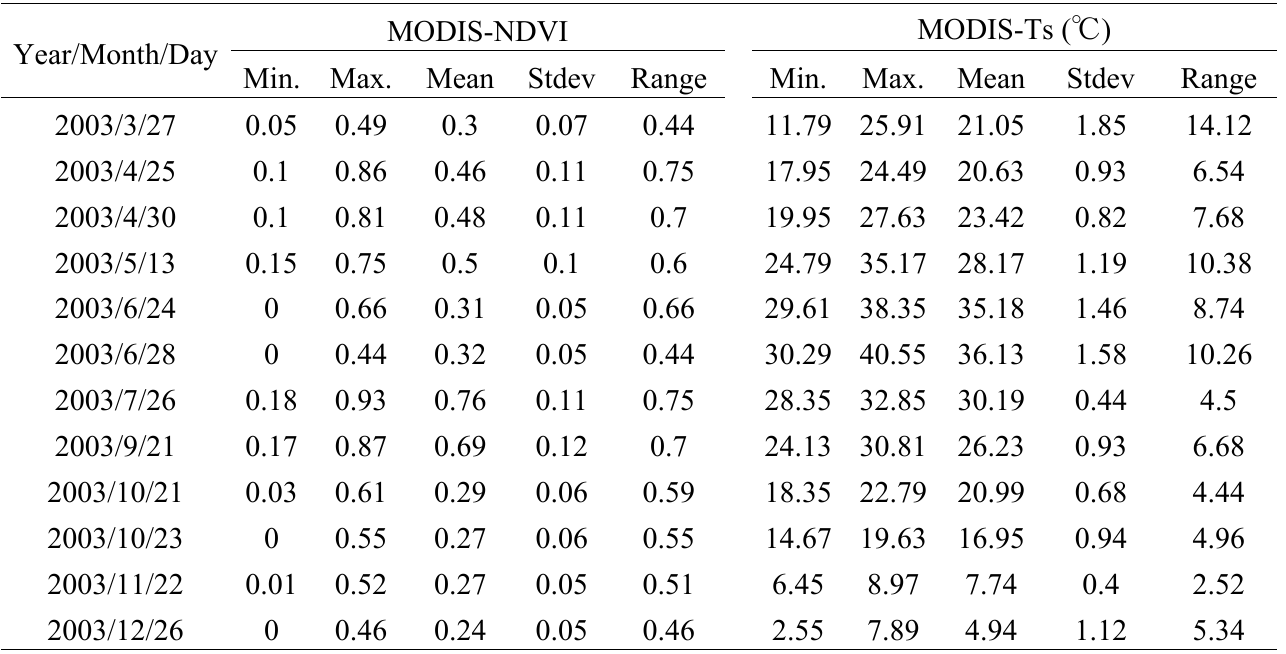
Table 2. Statistics of MODIS-NDVI and MODIS-Ts on 12 cloud-free days in